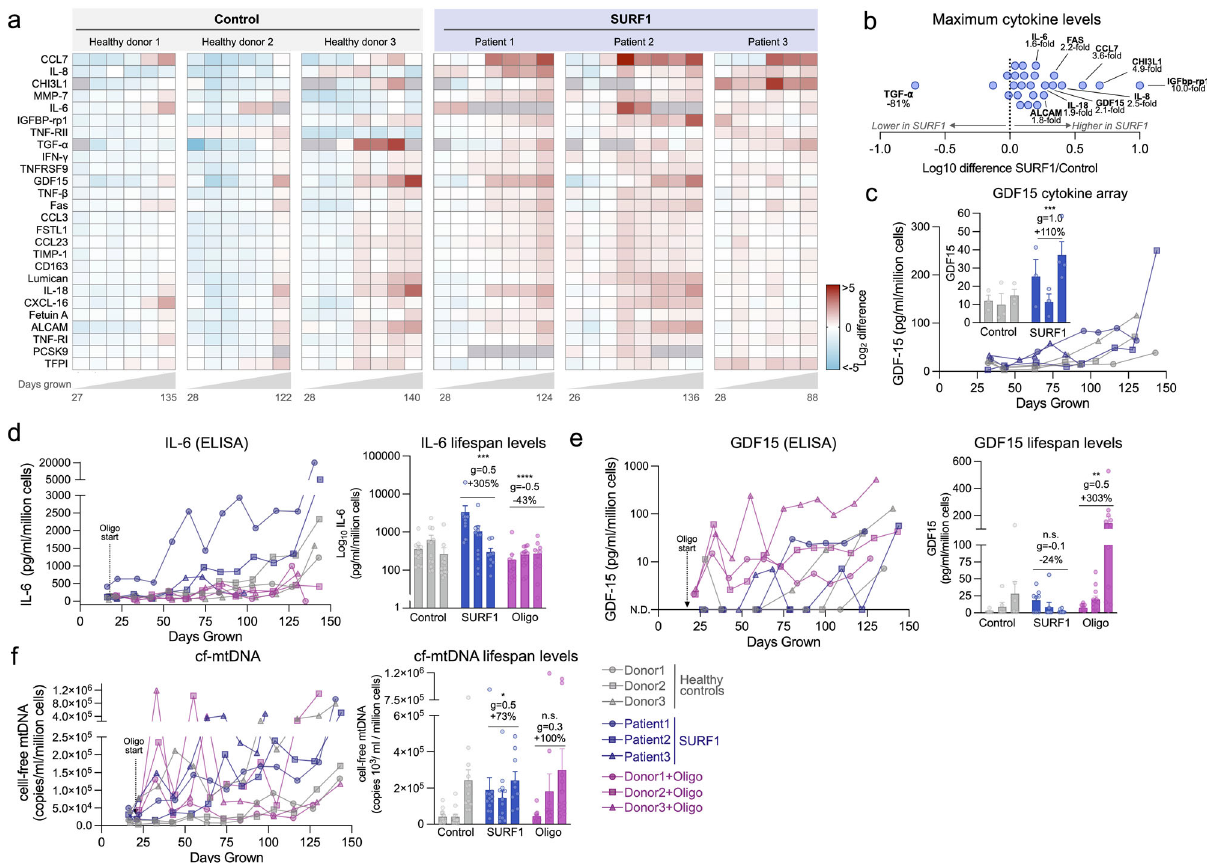
Fig. 5 OxPhos defects trigger hypersecretion of metabokines and age-related cytokines. a Cytokine dynamics across the lifespan measured on two multiplexes (Luminex) arrays. Cytokine levels are normalized to the number of cells at the time of sampling, shown as Log 2 median-centered for each cytokine; samples with undetectablevalues are shown as gray cells. Columns represent repeated measures ( n = 6 – 8) along the lifespan of each control and SURF1 donor ( n = 3 per group). b Comparison of maximum cytokineconcentration reached ineach ofthe SURF1and healthy control donors,showing general upregulation of most metabokines and cytokines. The value for TGF- α is heavily in fl uenced by a single very high value in Donor 3. c Cell-free media GDF15 concentration time course as measured on the Cytokine array. Inset compares early release between 20 and 80 days. d Media IL-6 levels across the cellular lifespan by enzyme- linked immunosorbent assay (ELISA), normalized to the number of cells at the time of sampling. e Media GDF15 levels across the cellular lifespan measured by ELISA, normalizedto thenumber ofcells atthe timeof sampling. Samples with non-detectable values (N.D.) areshown aszero values. f Cell-free mitochondrial DNA (cf-mtDNA) dynamics across the cellular lifespan using qPCR, normalized to the number of cells at the time of sampling. n = 3 per group, 6 – 13 timepoints per condition. Data are means ±SEM. * P < 0.05, ** P <0.01, *** P < 0.001, **** P < 0.0001, mixed effects model ( fi xed effect of Control/SURF1/Oligo group